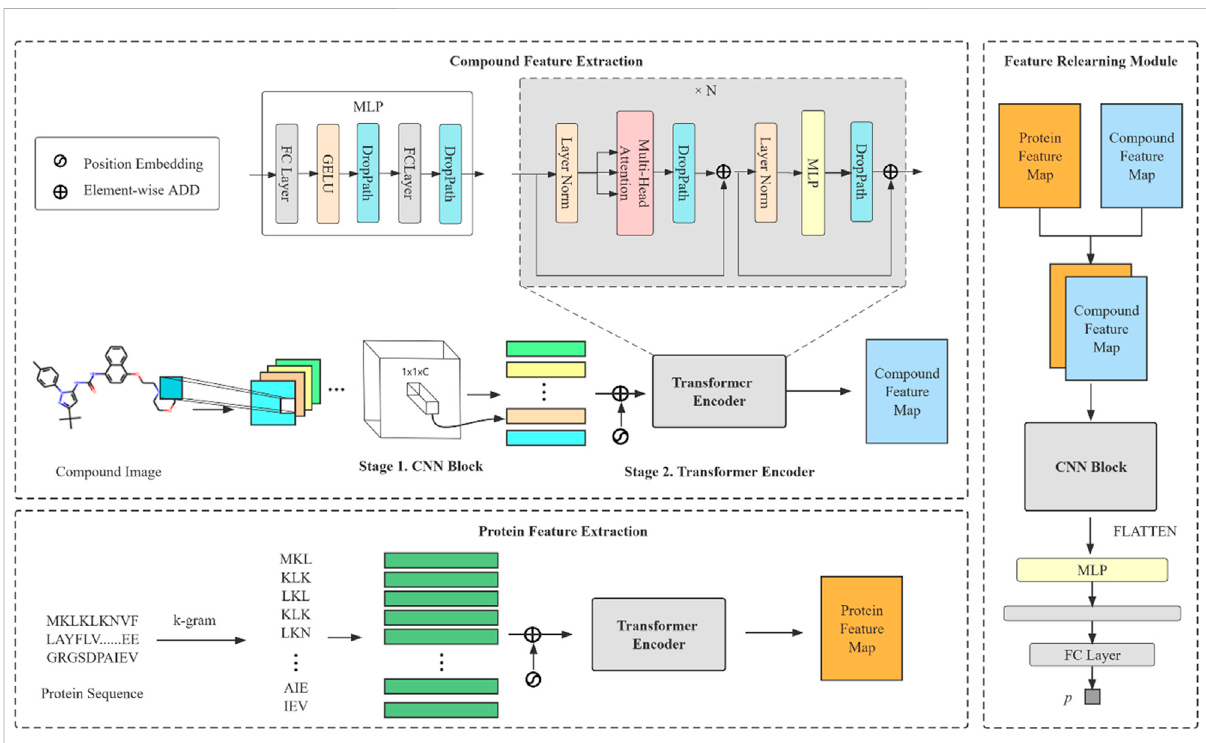
FIGURE 1 An overall architecture of the CAT-CPI. The model contains three modules: compound feature extraction, protein feature extraction and feature relearning